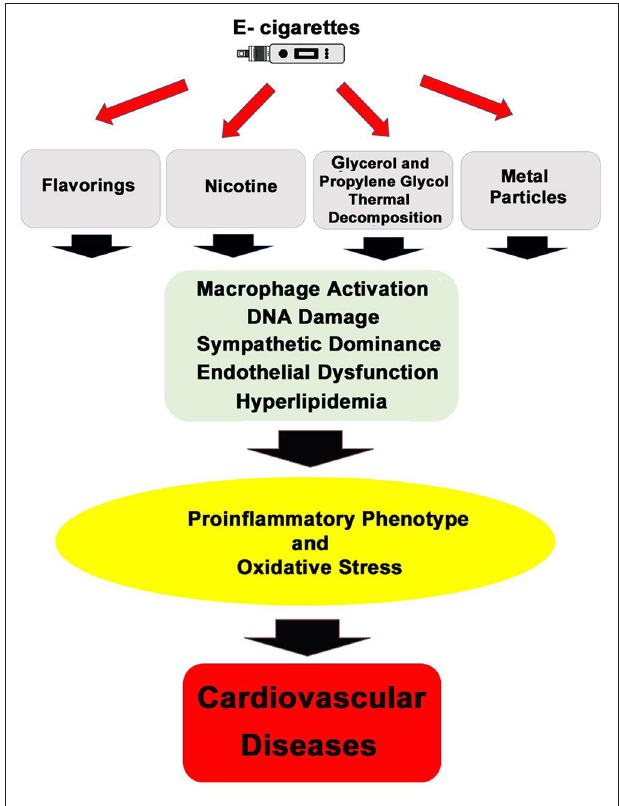
FIGURE 1 | General mechanisms of action by which inhalation of e-cigarettes’ aerosol can promote cardiovascular